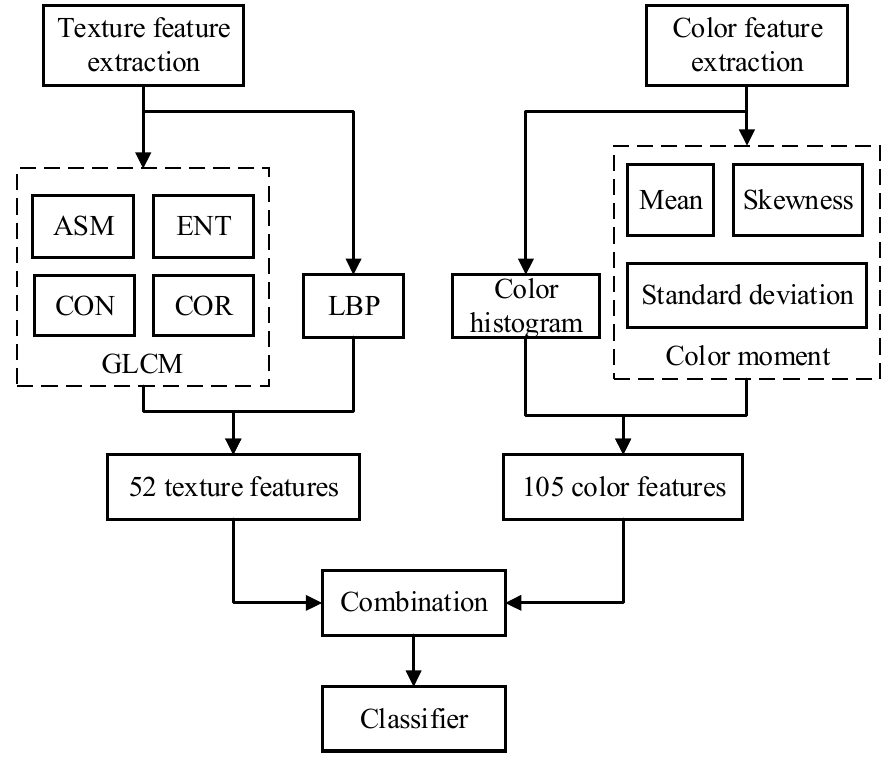
Figure 5. Flowchart of feature extraction.